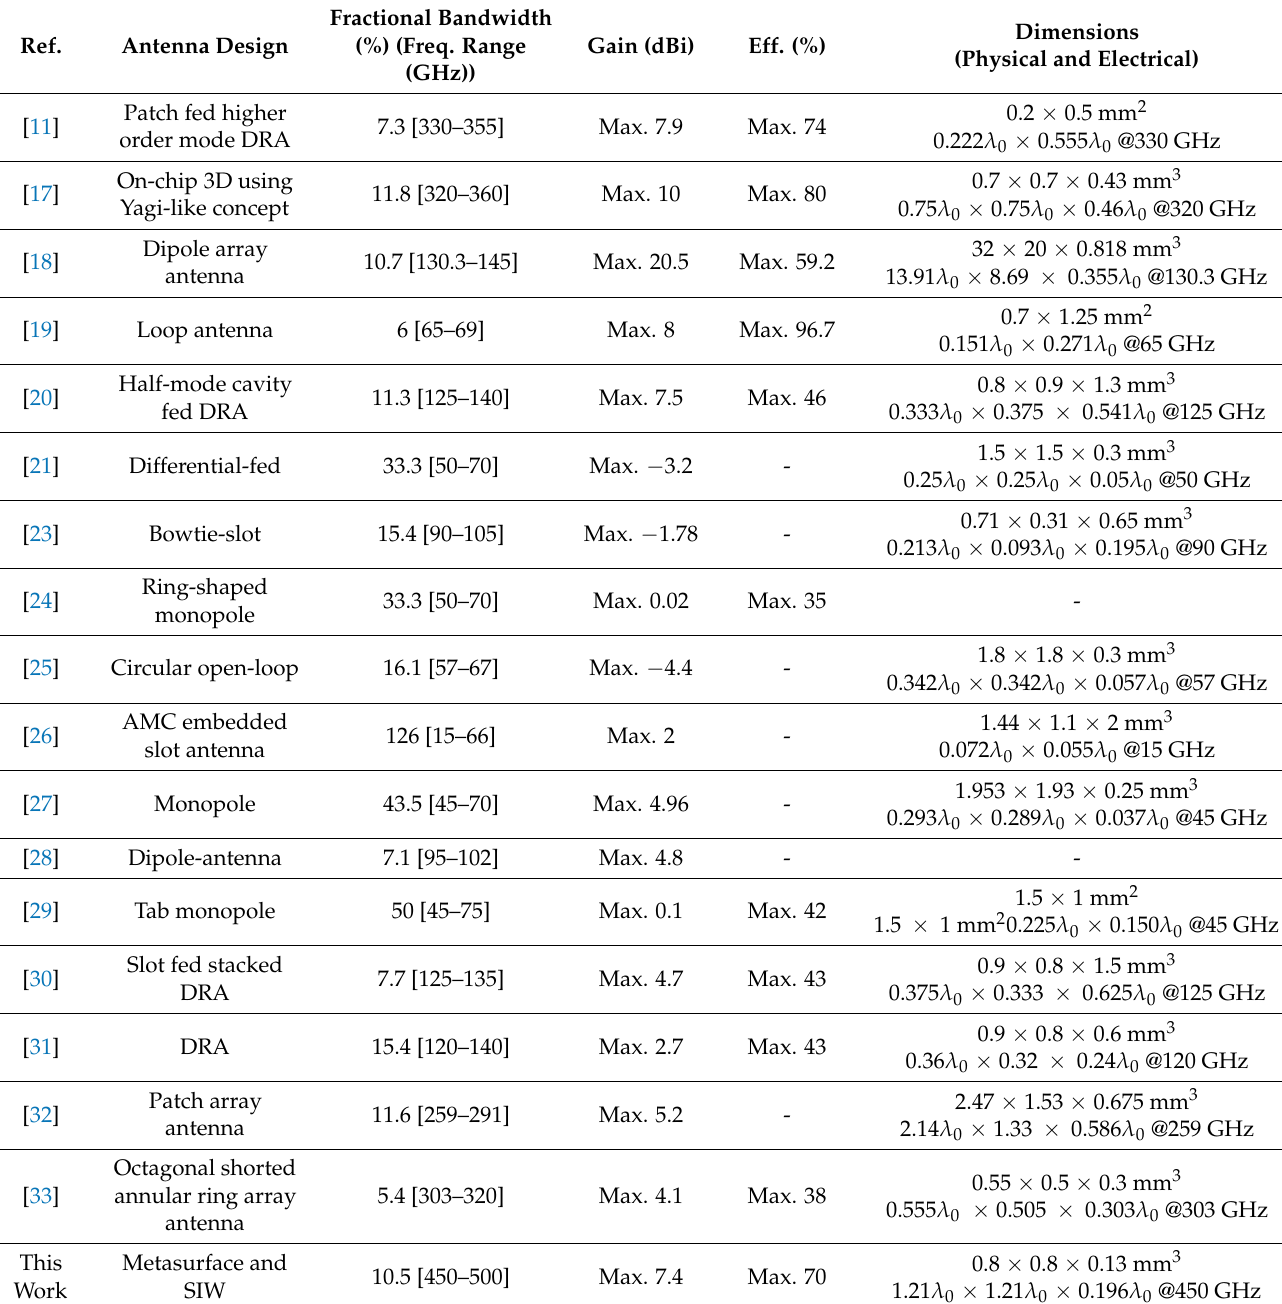
Table 2. Comparison of the proposed AoC with previous works reported in the literature.